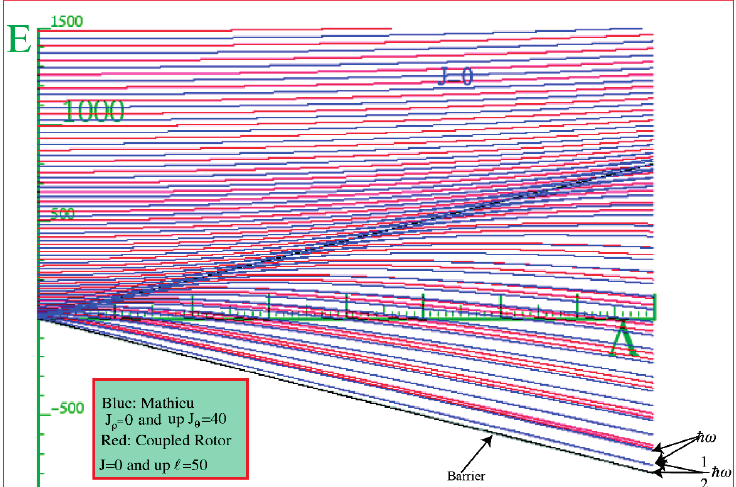
Figure 7. The comparison of the energy behavior above and behavior with the coupling constant between the two rotors model and the super-Mathieu for J = 0 and ℓ = 50